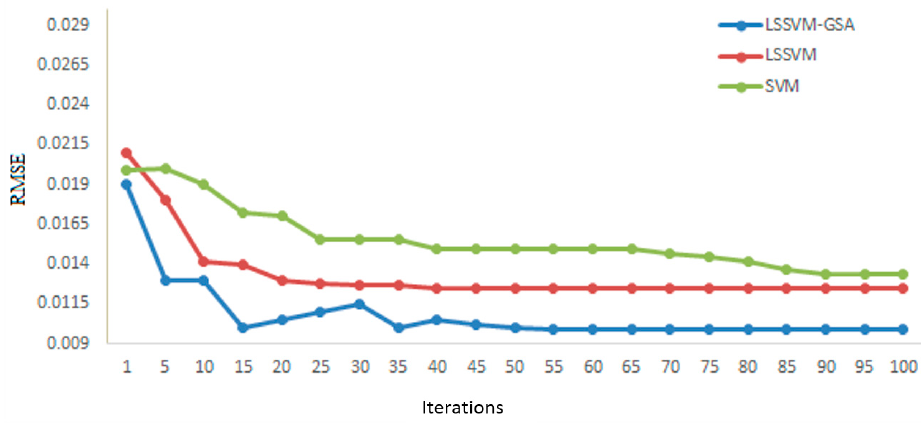
Figure 8. Taylor diagram of the observed and predicted C d by di ff erent models. Moreover, run times of the applied models were evaluated. The simulations were done in the MATLAB environment (MATLAB R2017b) using a computer with an operat- ing system of Windows 10 (64 bit) with an Intel(R) Core(TM) i5-10500 CPU @ 3.10 GHz processor with 16 GB RAM. In MATLAB R2017b, LS − SVM lab and Libsvm toolkit were utilized to develop the SVM and LSSVM models, respectively. Figure 9 provides the con- vergence graphs of the implemented models for the best input combination (M 5 ). For the best input scenario, the run times of the SVM, LSSVM and LSSVM − GSA models were 1.534 s, 0.027 s and 26.2 s, respectively. Although the computational cost of the LSSVM-